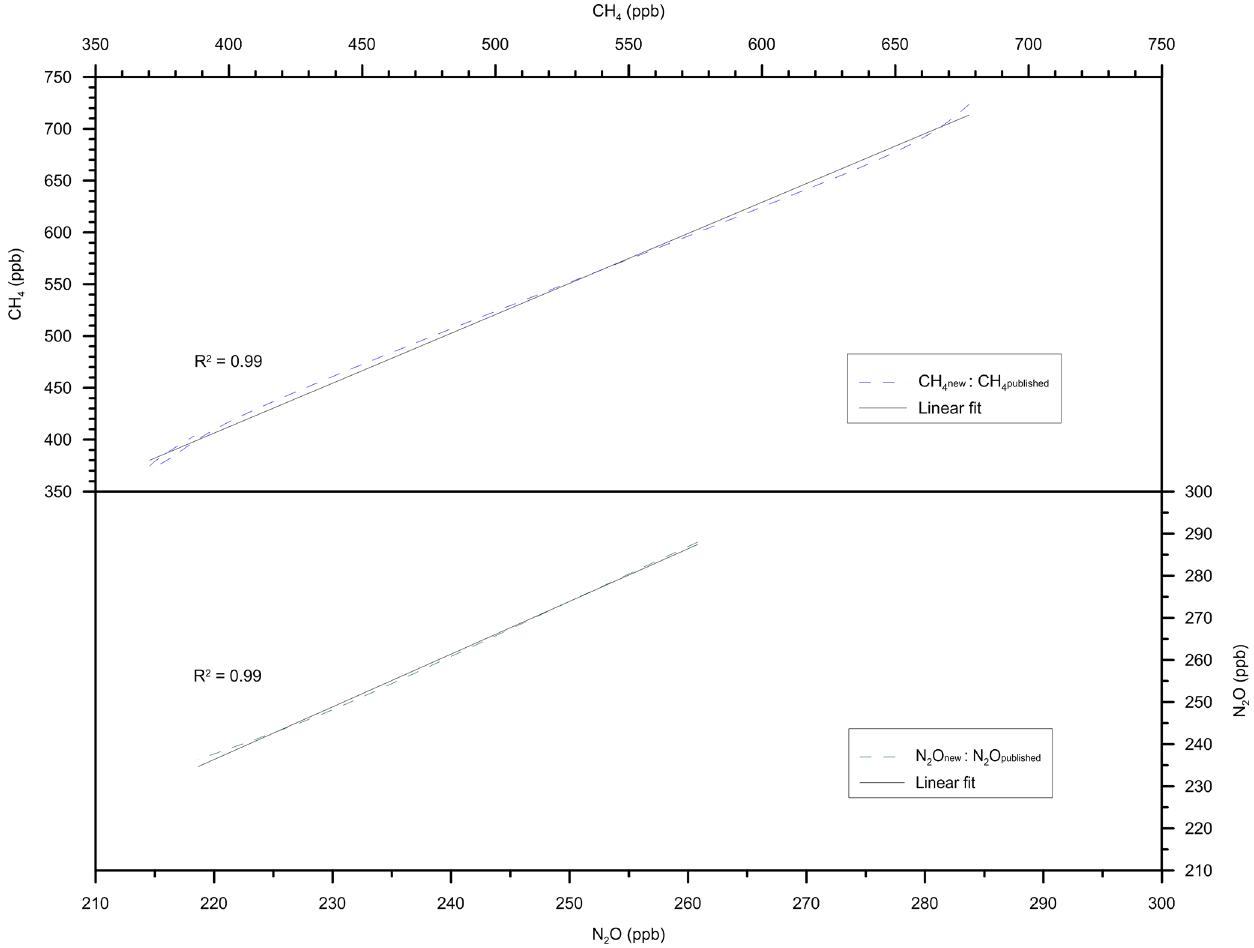
Figure B1. Offsets between new and published CH 4 and N 2 O EDC records. Dashed lines show the new measurements plotted against the published ones (data are from the spline approximations introduced in Appendix B). Solid lines are linear fits through these